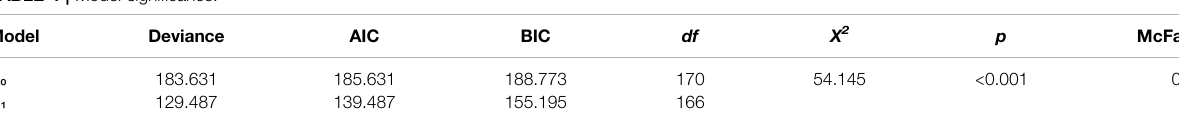
TABLE 4 | Model signi fi cance.